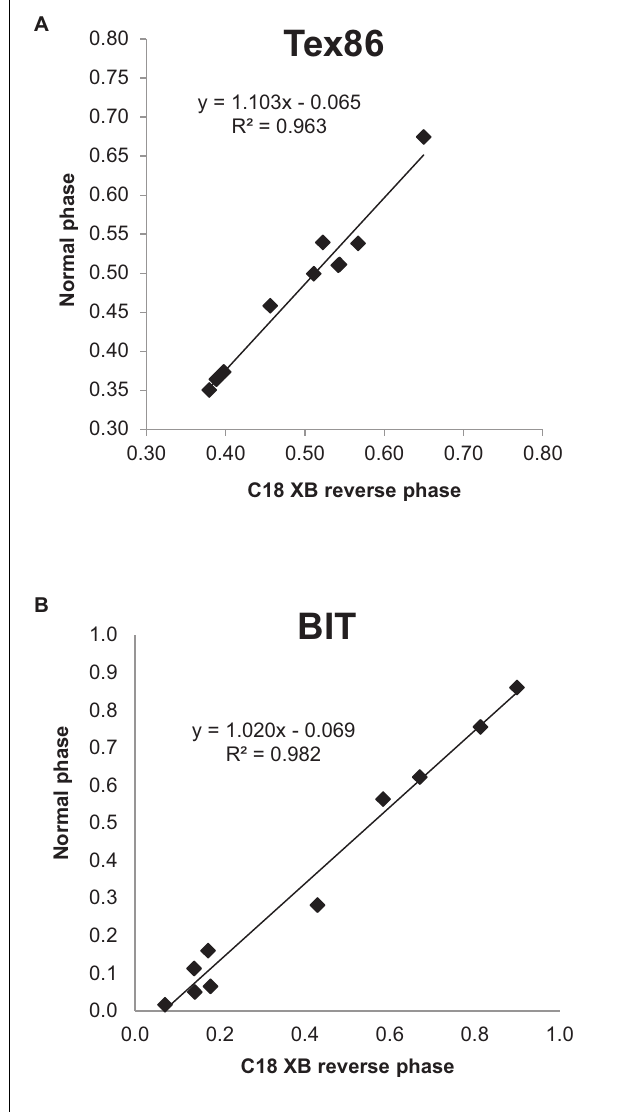
FIGURE 9 | Comparison of (A) BIT and (B) TEX 86 values obtained by Normal Phase (Cyano column) and Reverse Phase (C18-XB) chromatography.